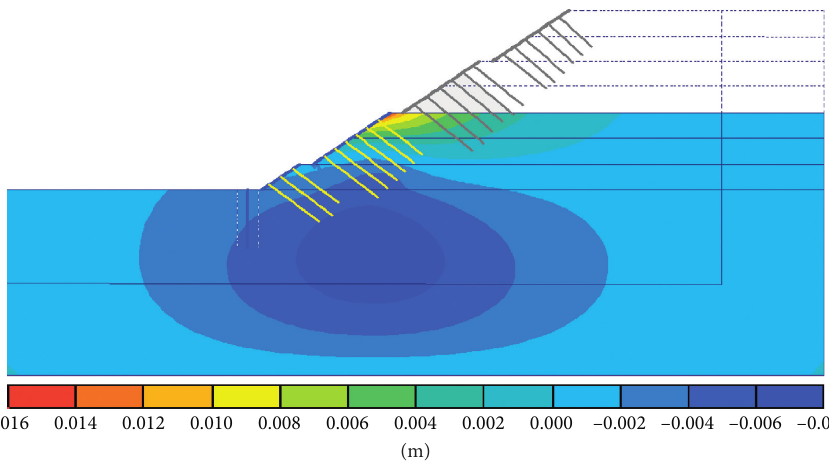
Figure 10: Horizontal displacement nephogram of slope working condition 4 under reinforcement measures.